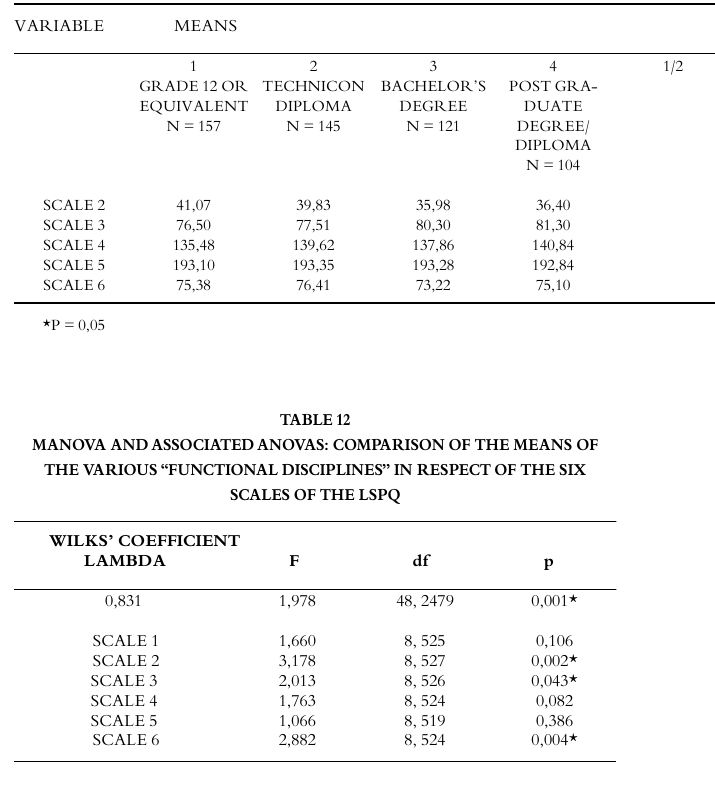
TABLE13 SCHEFFE’SPOST-HOCMULTIPLECOMPARISONS: COMPARISONOF